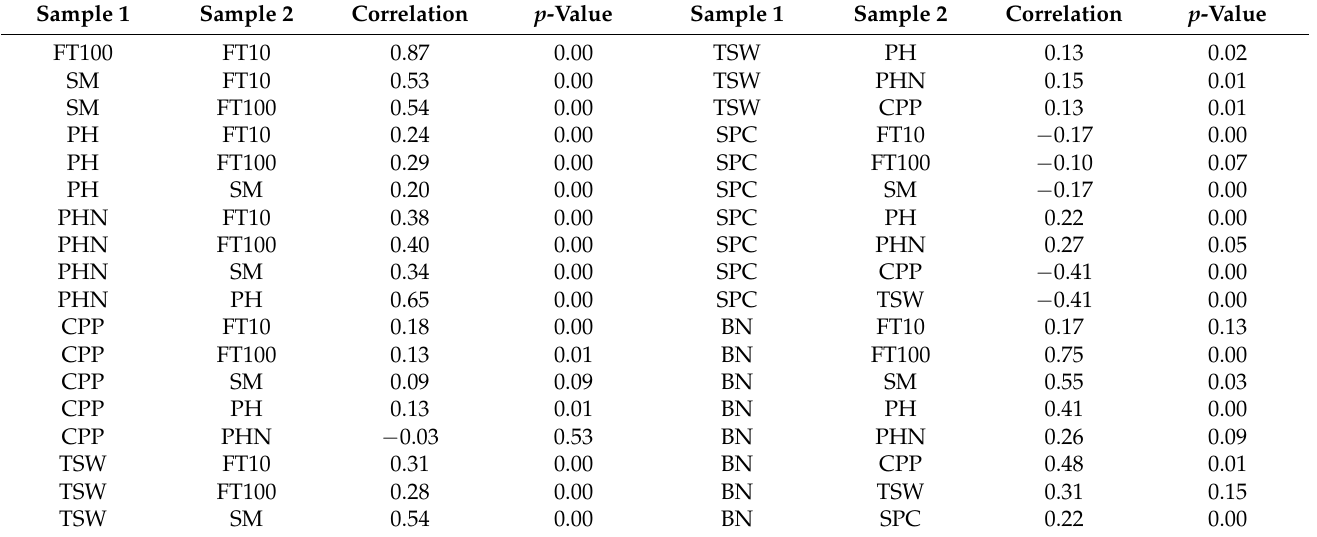
Table 3. The measured correlation and significant level of independent variables.